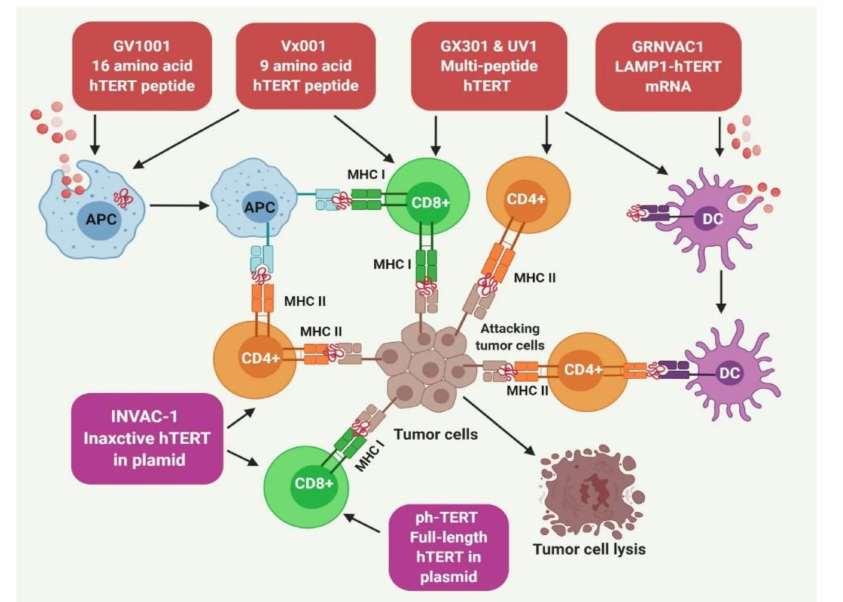
Figure 3. Telomerase-based immunotherapy and the role of the immune system in eliminating cancer cells.